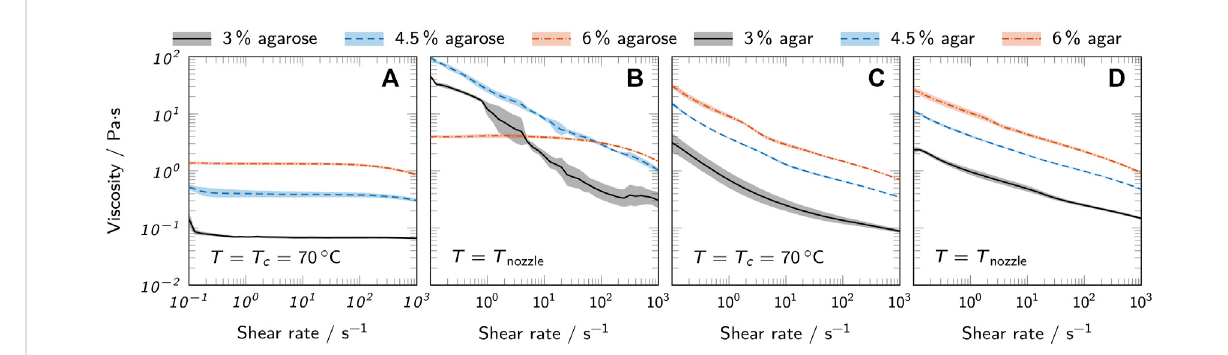
FIGURE 4 Viscosity curves of all prepared bioinks at 70 ° C and the respective nozzle temperature T nozzle used for printing. Low-melt agarose bioinks at (A) 70 ° C and (B) T nozzle are compared to agar bioinks at (C) 70 ° C and (D) T nozzle . All curves show mean values and the standard deviation as shaded areas ( n = 3).